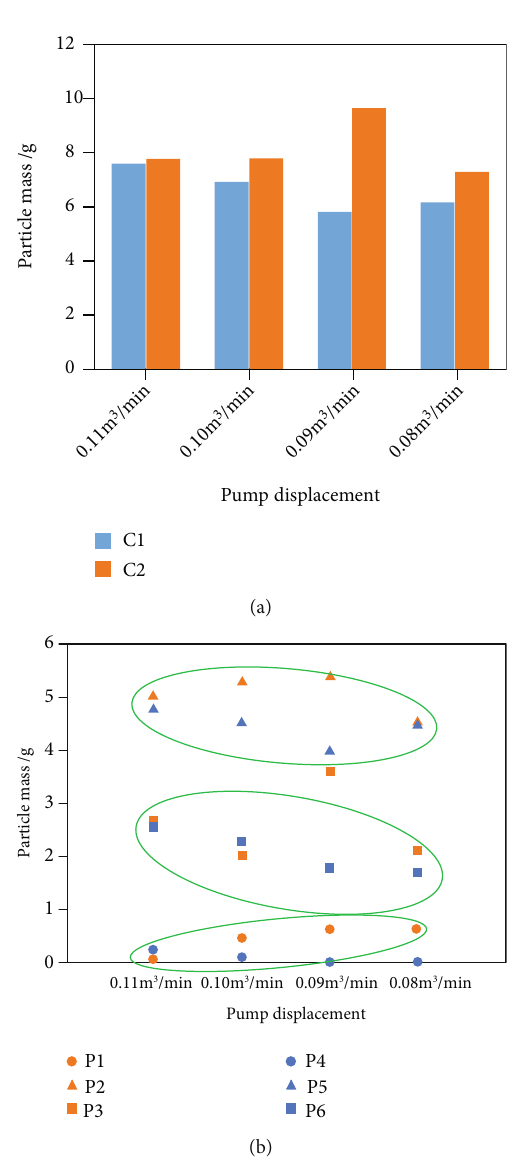
Figure 7: The settlement mass of the temporary plugging particles in each cluster (a) and perforation (b) under di ff erent pump displacements (orange red is the perforation at the outlet end, blue is the perforation at the inlet end, and P represents the perforation). Table 4: Add sequence experiment